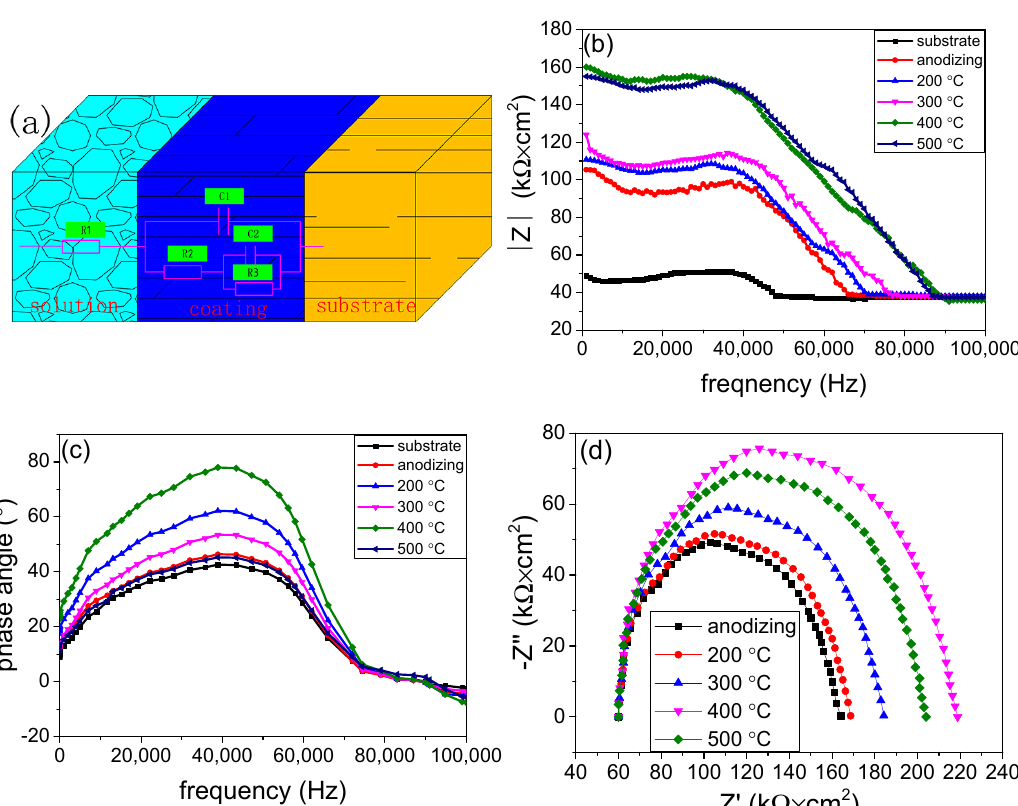
Figure 6. The ( a ) equivalent circuit diagram, ( b ) Bode impedance–frequency plot, ( c ) Bode phase angle–frequency plot and ( d ) Nyquist plot of Al substrate, anodic coating before and after being treated at 200 °C, 300 °C, 400 °C, and 500 °C. Note: before being characterized, all the samples were immersed in 3.5 wt.% NaCl solution for 1 day at room temperature.